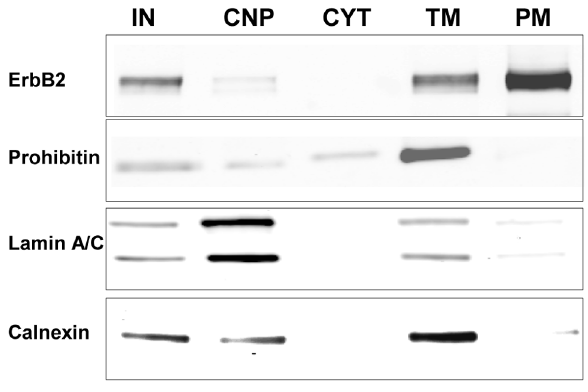
Figure 2. Western blots illustrate the purification of plasma membrane proteins using an aqueous two-phase system. SK- BR-3 plasma membranes were isolated, and the input (IN), crude nuclear pellet (CNP) which also contained unlysed whole cells, cytosol (CYT), total cellular membranes (TM) which included nuclear, mito- chondrial, endoplasmic reticular, and plasma membranes, and purified plasma membranes (PM) were subjected to Western blot analysis. ErbB2 is plasma membrane based, prohibitin is anchored in mitochondrial membranes, lamin A/C is found in nuclear membranes, and calnexin is an endoplasmic reticulum protein. All lanes were loaded at 10 m g protein/lane.